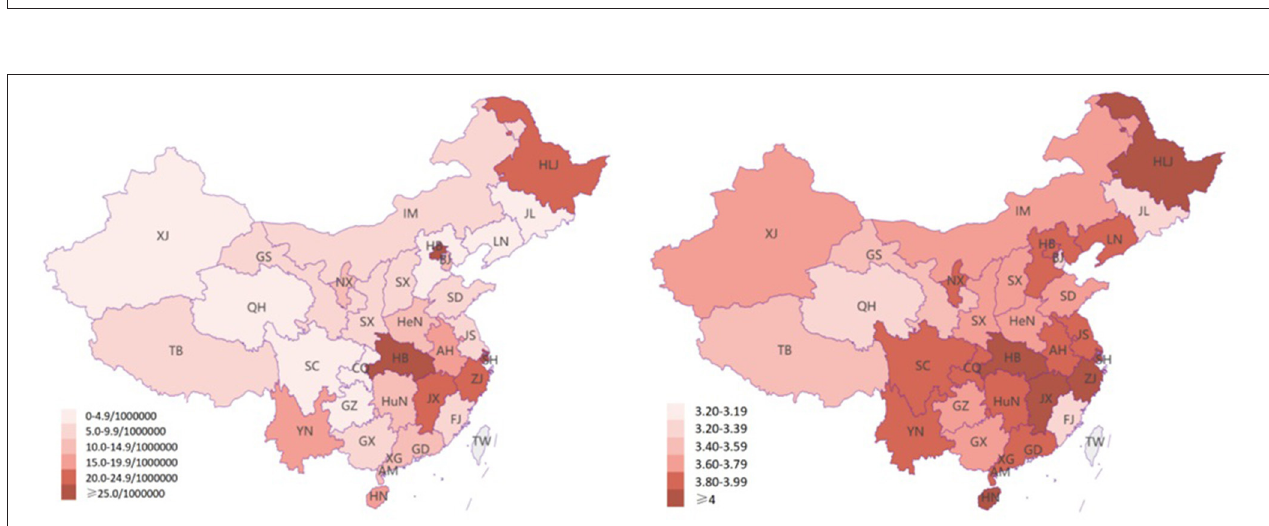
FIGURE 1 | Factors affecting mental health during the COVID-19 outbreak. IK, Insufficient knowledge and understanding of epidemic prevention measures; LO, Lack of effective epidemic prevention equipment; IO, Impact on work processes; EI, Impact on economic income; WA, Worries about being infected; CA, Concerns about students’ learning; LI, Limitations in daily life and social interaction; SI, Spread of large amounts of negative information about the epidemic; PH, Prolonged home quarantine; ES, Epidemic severity.